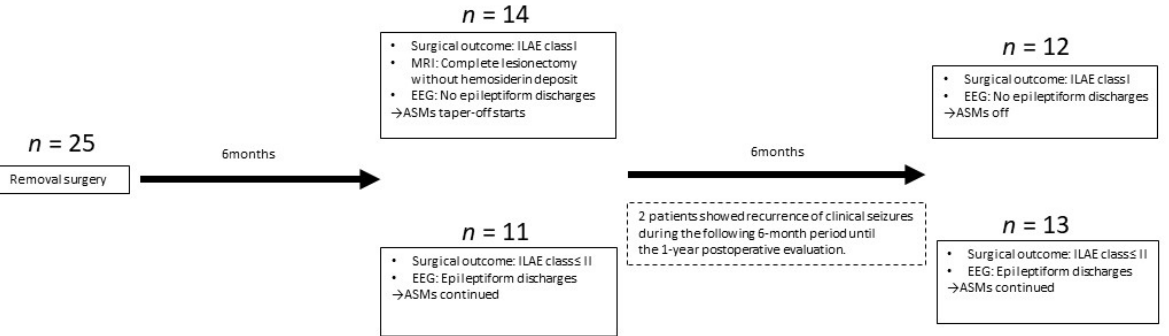
Figure 1. Patient assignment to No-ASM and ASM groups. Overall, 12 patients satisfied the con- ditions for inclusion in the no-anti-seizure medication (ASM) group (48%), and 13 patients (52%) (3 patients with clinical seizures and 10 patients with epileptiform discharges without clinical seizures) were assigned to the ASM group a year after surgery.